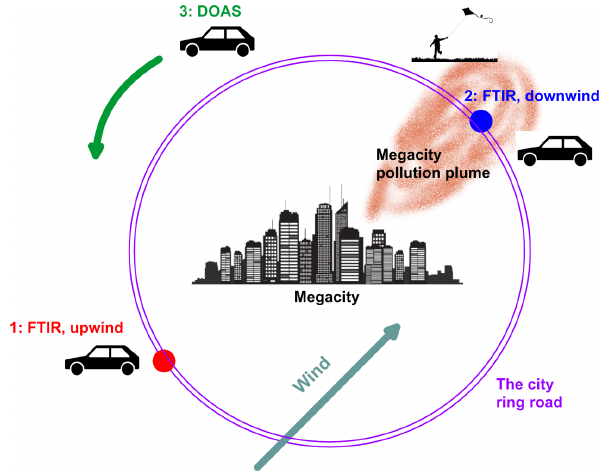
Figure 1. Illustration of the concept of EMME: two FTIR spectrom- eters at the upwind and downwind locations on opposite sides of the city (no. 1 and no. 2, red and blue dots) and circular moving DOAS technique spectrometer (no. 3). Ground-level air samples were col- lected at locations no. 2 and no. 3. Collecting air portions with the help of a kite was done usually at the downwind location under suitable weather and landscape conditions. Pictogram png images: https://www.cleanpng.com/, last access: 6 November